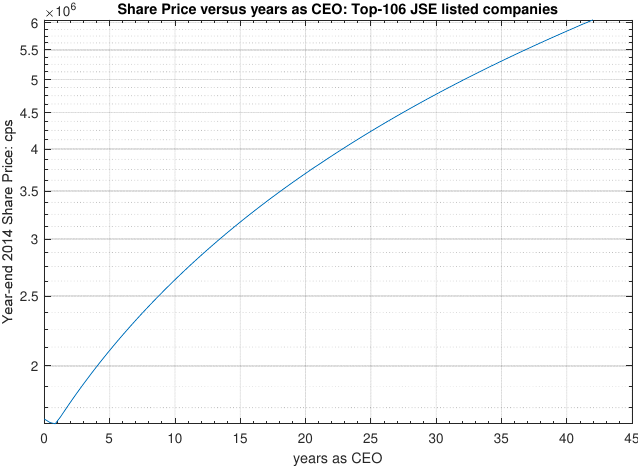
Figure 5 is a plot of three ANOVA functions: single-response